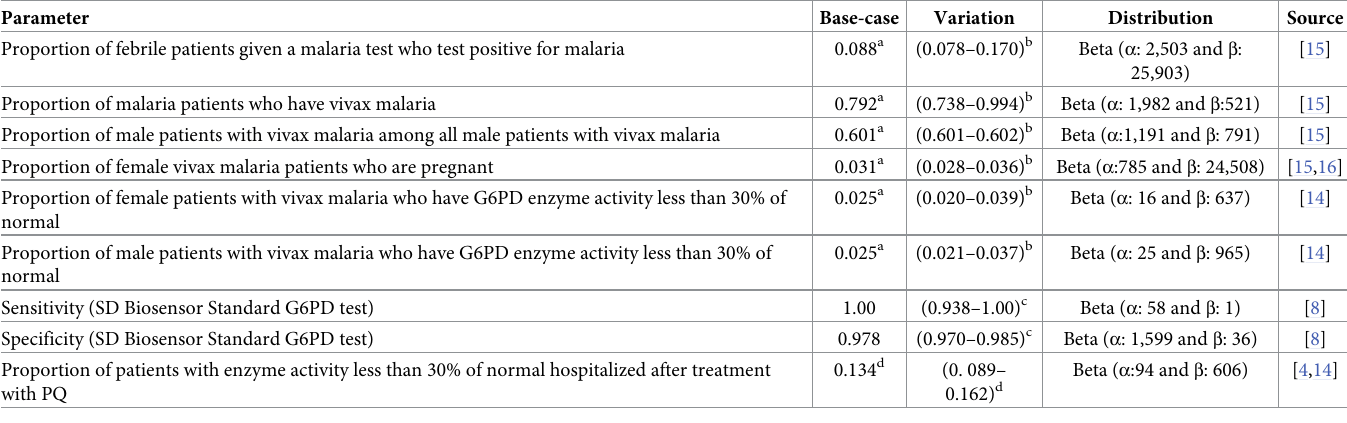
Table 1. Epidemiological parameters considered in the analytical model for the Brazilian